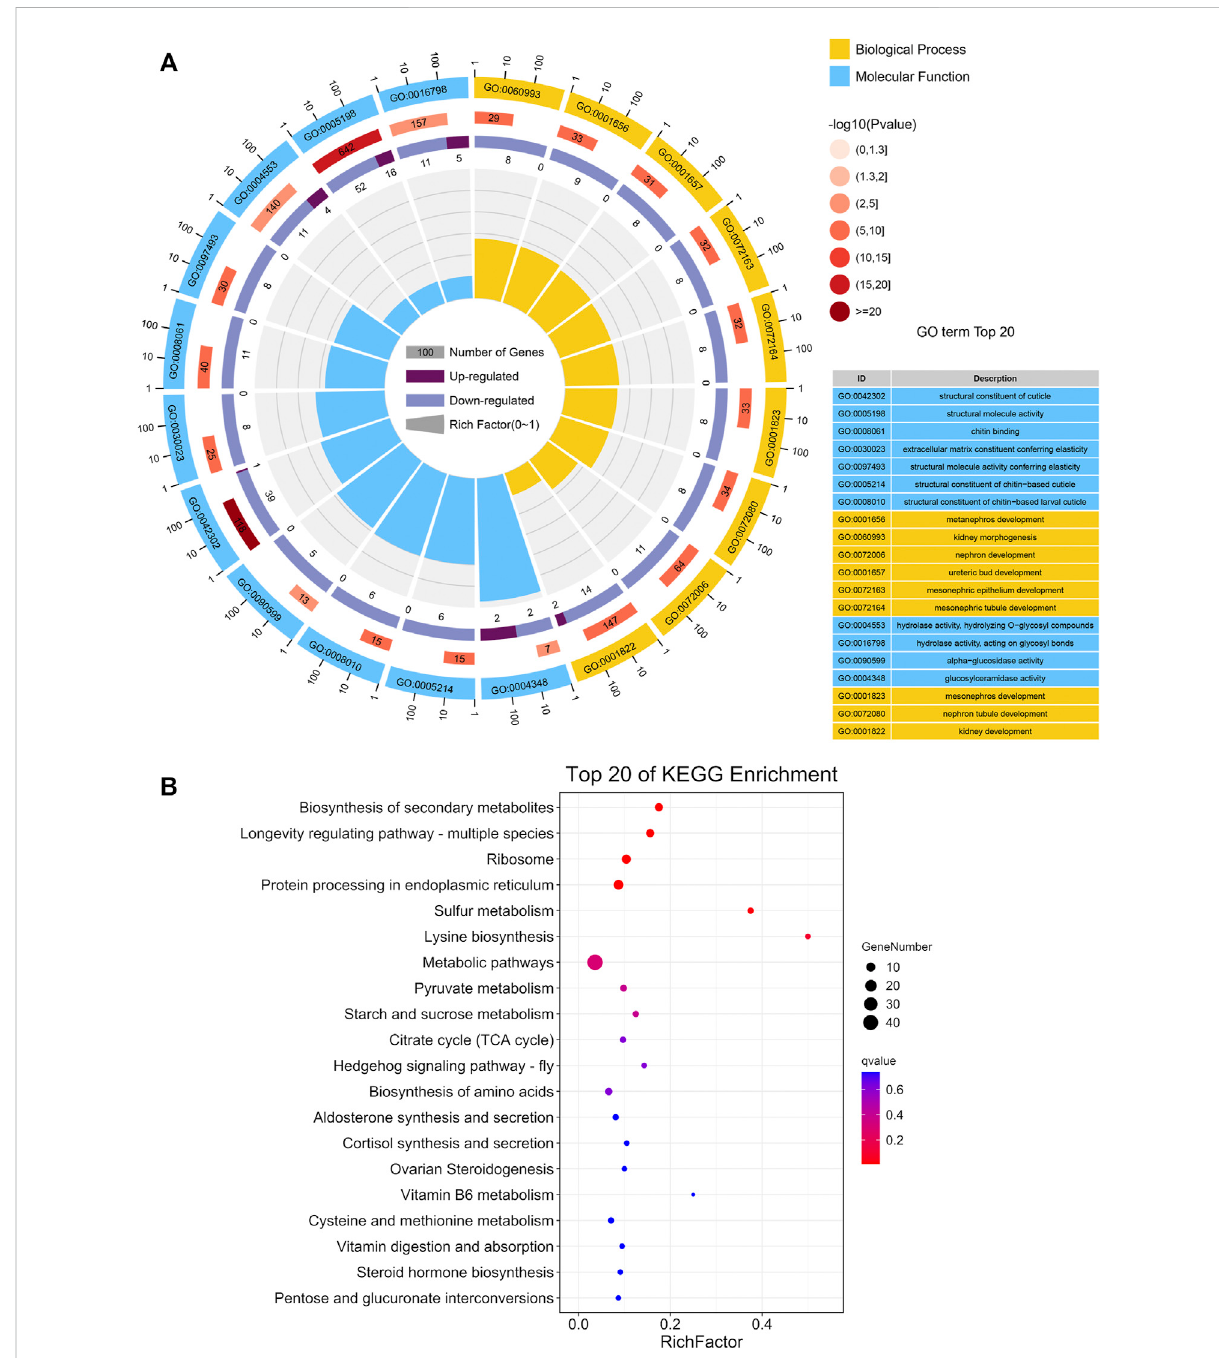
FIGURE 3 Functional CLassi fi cation of DEGs between BPH reared on RH and TN1 varieties. (A) GO enrichment analysis of the DEGs. The outer ring represents the number of the top 20 enriched GO terms, and different colors indicate different ontologies. Ring 2 represents the gene counts in the whole genome background, and the color changes according to the Q-value of the enrichment analysis. Ring 3 represents the counts for upregulatedanddownregulatedgenesincorrespondingGOterms.Ring4indicatestherichfactor(thenumberofDEGsdividedbythenumber of background genes in the corresponding term). (B) The DEGs in the Kyoto Encyclopedia of Genes and Genomes metabolic